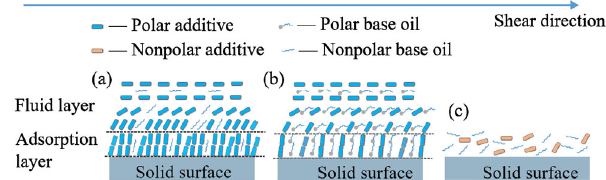
Fig. 6 (a) Relative change in intensity ratio in different areas of the contact region as compared with that in the bulk region (100%); (b) the center film thickness; (c) the interference image in the contact region of Lubricant 1–4.